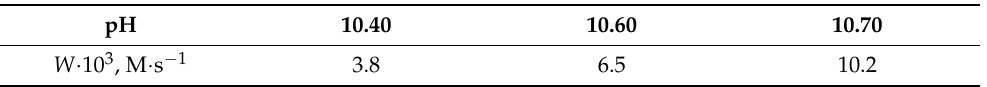
Table 1. Comparison of the rates of adrenaline consumption ( W ) at different pH. Carbonate buffer, [Adr] 0 = 68 µ M, air atmosphere, 310 K.